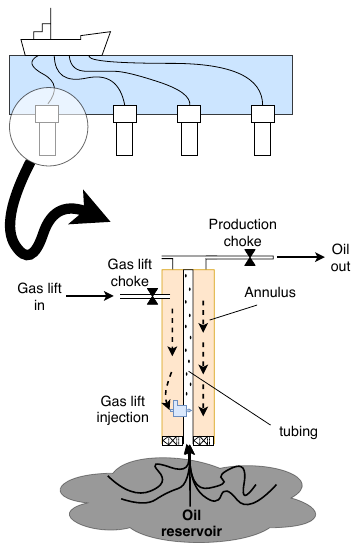
Figure 2. A simplified representation of the gas-lift oil well system.